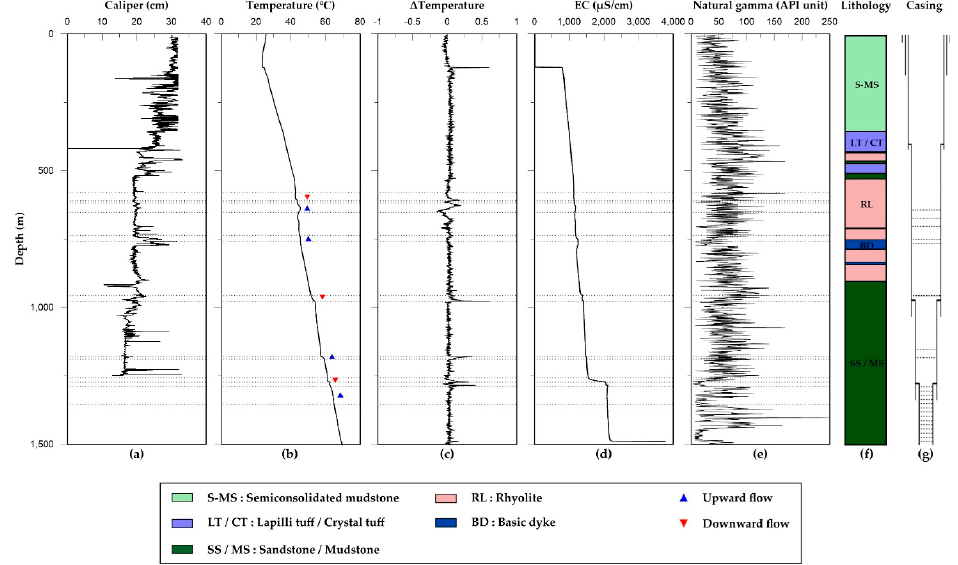
Figure 6. Geophysical and lithological profiles of BH-2: ( a ) Caliper log; ( b ) temperature log; ( c ) delta temperature log; ( d ) electrical conductivity (EC) log; ( e ) natural gamma-ray log; ( f ) a simplified lithological log; and ( g ) a casing installation. The blue triangle indicates upward ground flow and the red upside-down triangle indicates downward ground flow. Estimated depth intervals where groundwater flows occurred are marked with dotted lines.